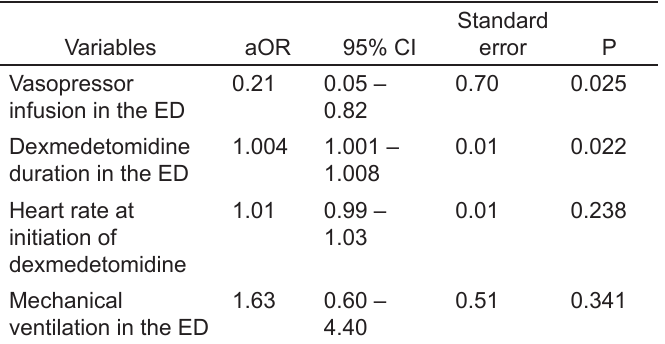
Table 4. Multivariable logistic regression analysis with a composite of hypotension and bradycardia as the dependent